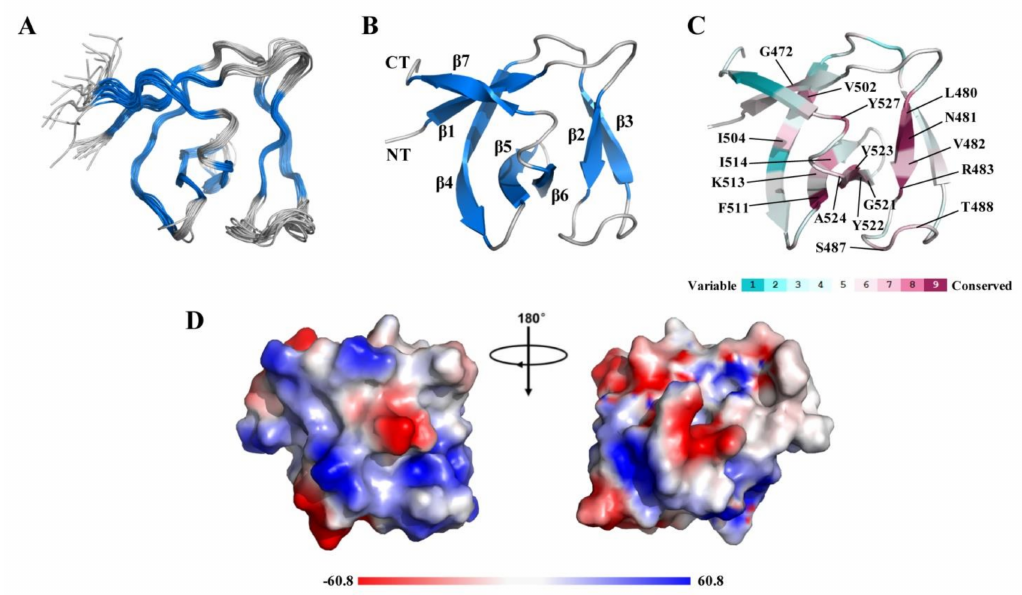
Figure 2. Solution NMR structure of CpAcp SH3b6. ( A ) Superposition of the backbone traces of 20 conformers of CpAcp SH3b6 with lowest energy. The β -strands are colored in marine blue and the loops are in gray. ( B ) The cartoon representation of CpAcp SH3b6 structure with β -strands labeled. CT, C-terminus; NT, N-terminus. ( C ) ConSurf analysis with the nine-color conservation scores projected onto CpAcp SH3b6 structure with the lowest energy. Residues with conservation score over 7 are indicated. ( D ) Electrostatic surface potential diagrams of CpAcp SH3b6 colored by electrostatic